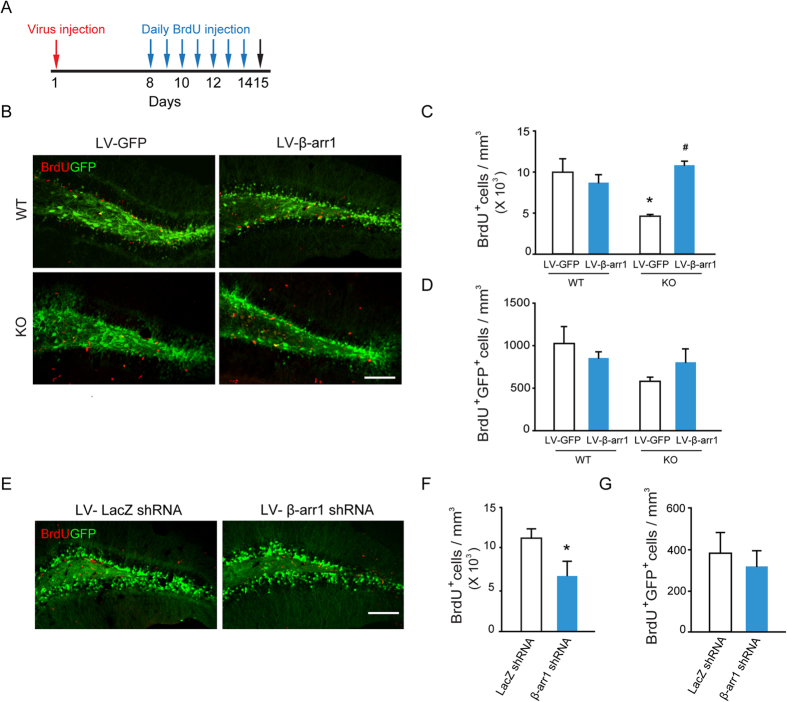
β-arr1 in the DG Regulates the Proliferation of Neural Precursors.One week after injection of lentivirus encoding GFP (LV-GFP), β-arr1 and GFP (LV-β-arr1), or GFP plus β-arr1 shRNA (LV-β-arr1 shRNA) or β-galactosidase shRNA (LV-LacZ shRNA) into the DG, mice were treated daily with BrdU (100 mg/kg i.p.) for 7 days and sacrificed 1 day after the last BrdU injection. (A) Schematic of experimental schedule. (B–D) Expression of LV-β-arr1 and LV-GFP. *p < 0.05 vs. WT/LV-GFP; #p < 0.05 vs. KO/LV-GFP, two-way ANOVA, post hoc Tukey test. (E–G) Expression of LV-β-arr1 shRNA and LV-LacZ shRNA. *p < 0.05, t-test, BrdU+ cell and BrdU+ GFP+ cell number in the SGZ are normalized to the GCL volume (in mm3). Values represent mean ± s.e.m.; n = 3–4 for each group; Scale bar, 100 μm.